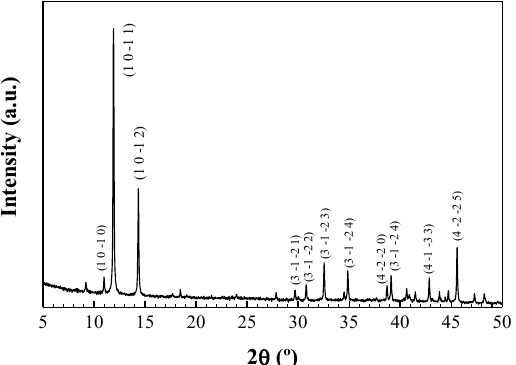
Figure 3. Experimental X-ray powder diffraction patterns for Mo 15 S 19 nanoparticles. Four-index notation of the Miller indices has been used to allow direct comparison with the diffractograms reported in the literature [3,4].